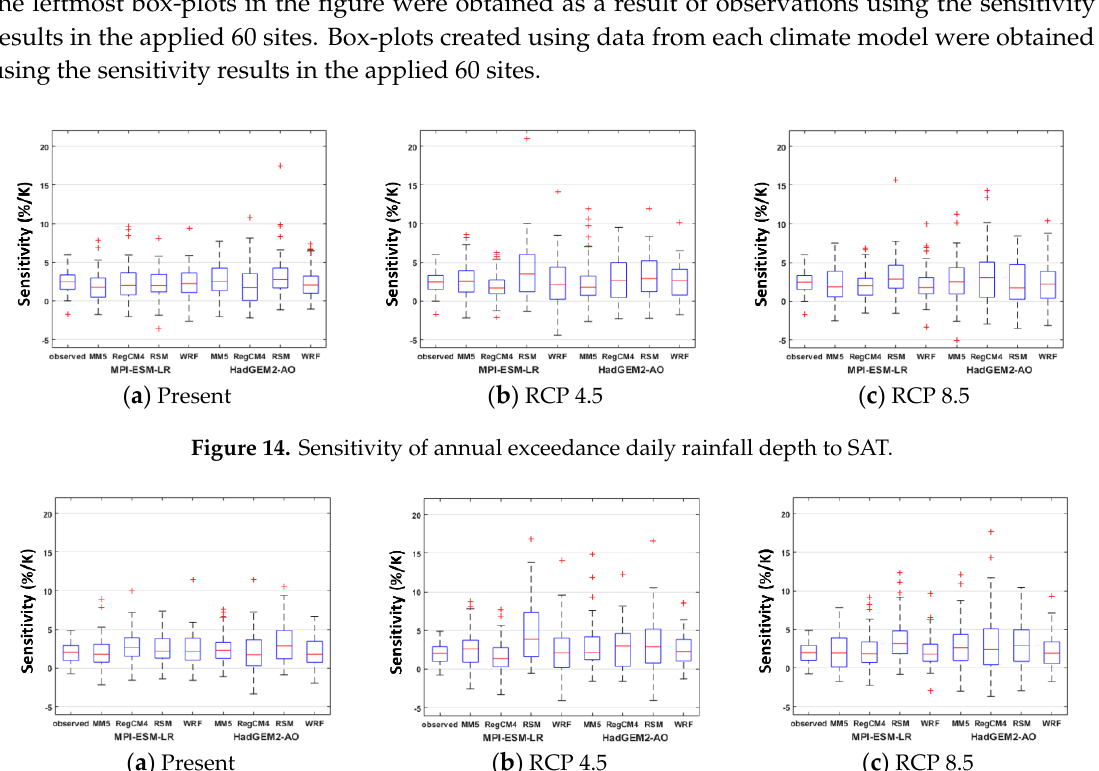
Figure 13. Change rate of annual exceedance daily rainfall depth.